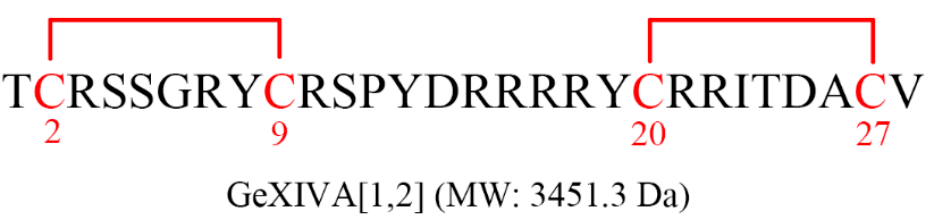
Figure 1. Amino acid sequence of GeXIVA[1,2]. GeXIVA[1,2] is a 28-amino acid peptide. It includes 4 cysteines with disulfide bonds between Cys2–Cys9 and Cys20–Cys27. Red lines indicate the disulfide bonds.